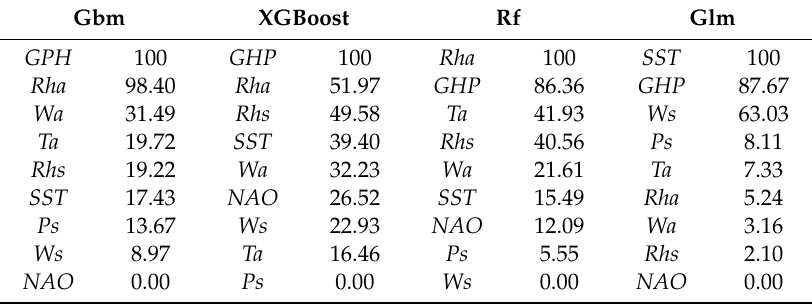
Table 5. Scaled values of the relevance of predictors for gbm, XGBoost, rf, and glm models. Gbm XGBoost Rf Glm GPH 100 GHP